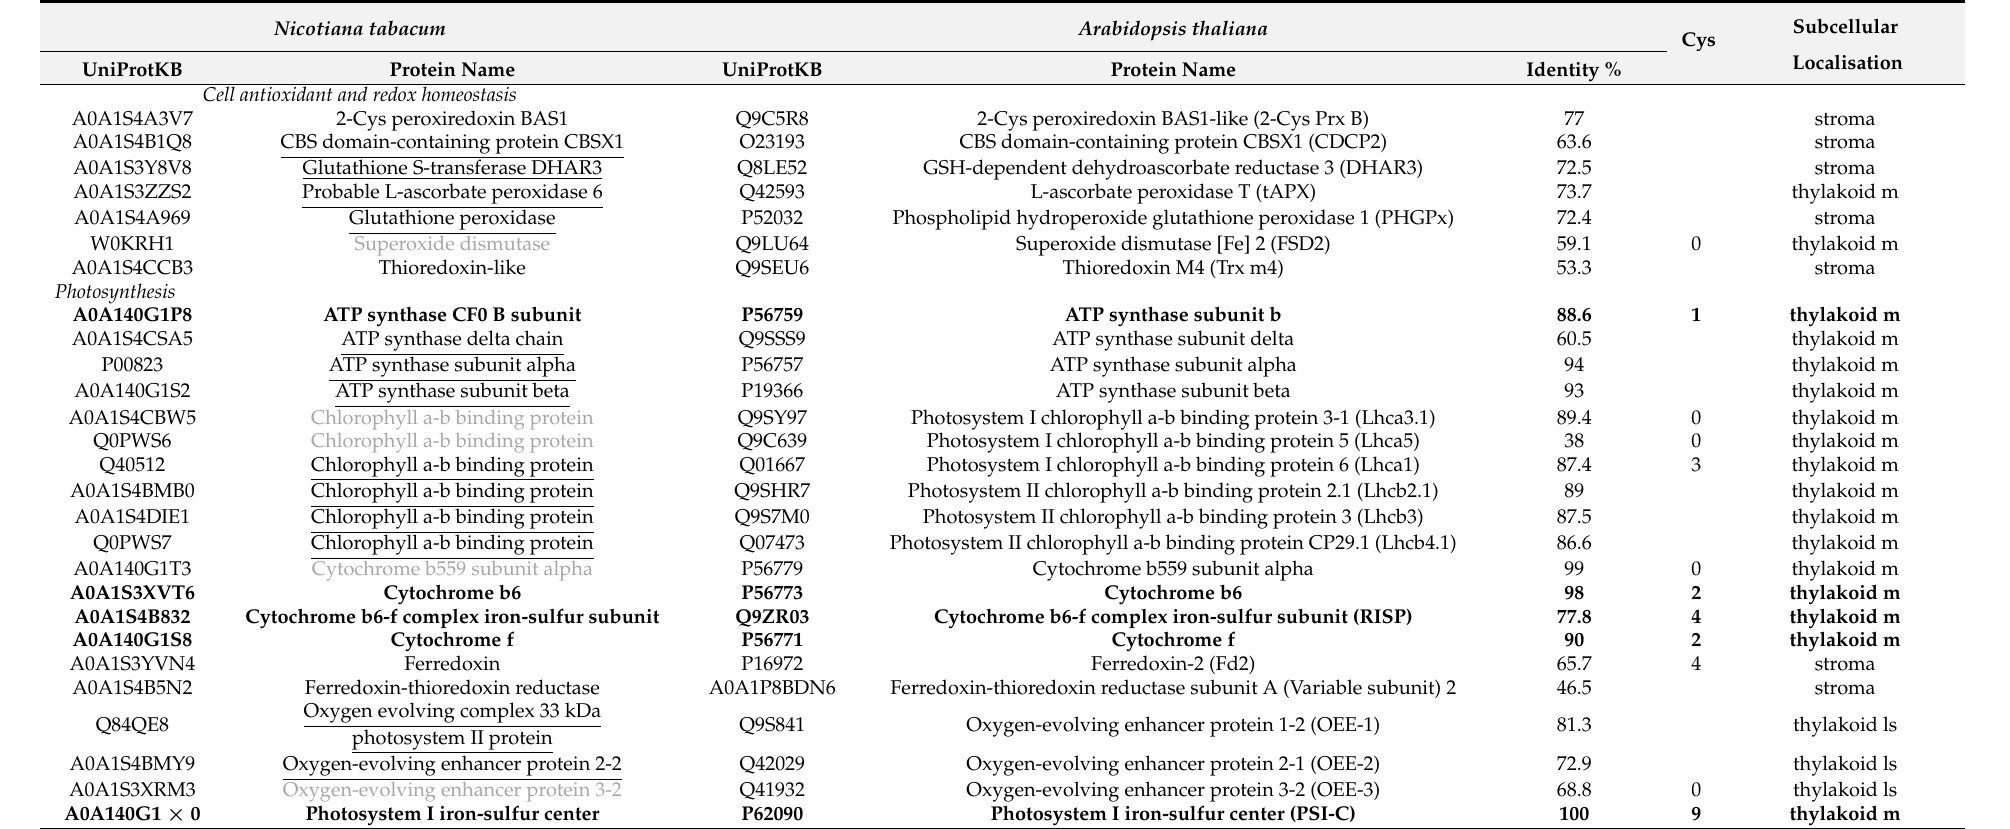
Table 2. List of chloroplast proteins identified as potential NTRC targets by in vivo interaction with the monocysteinic mutant through agroinfiltration of N. benthamiana plants. The table shows identified proteins in an N. tabacum database, as well as their orthologs in Arabidopsis , with the corresponding identity %. Localisation inside the chloroplast is indicated. The new potential targets for any Trx type are indicated in bold and the number of conserved Cys residues is shown. The proteins previously identified as targets of other Trx types, except for NTRC, are underlined. The proteins located in the lumen or without conserved Cys residues are indicated in grey text. Thylakoid m: thylakoid membrane; Thylakoid ls: thylakoid lumenal